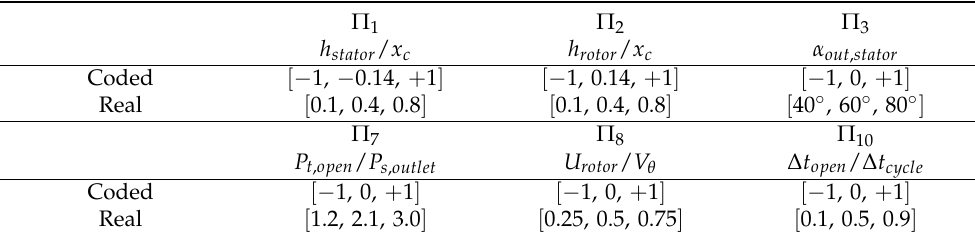
Table 4. Factors and experimental domain of the surface response design.